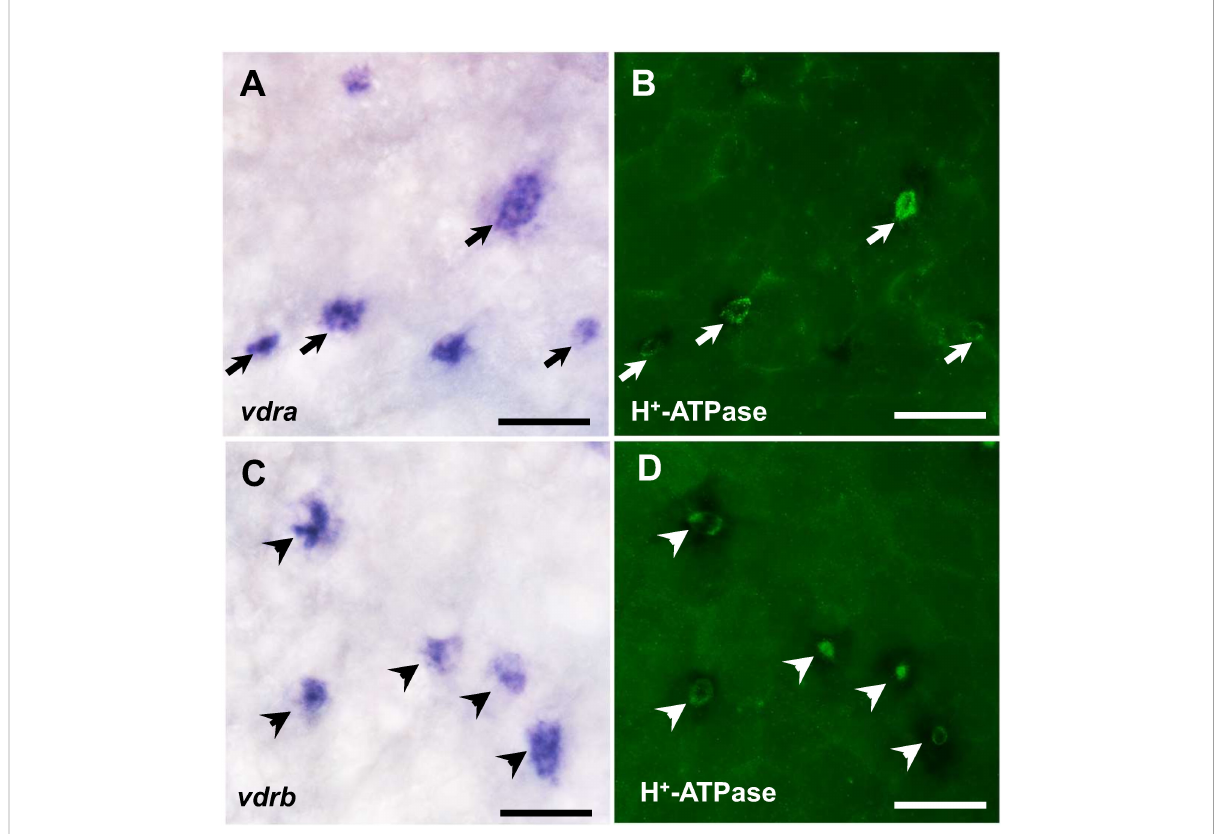
FIGURE 3 In situ hybridization staining of vdra and vdrb (A, C) and immunocytochemical staining of H + -ATPase (B, D) in 3 dpf zebra fi sh larvae. Co- localization of vdra mRNA and H + -ATPase protein signals in the same cell is indicated by arrows. Scale bar: 20 m